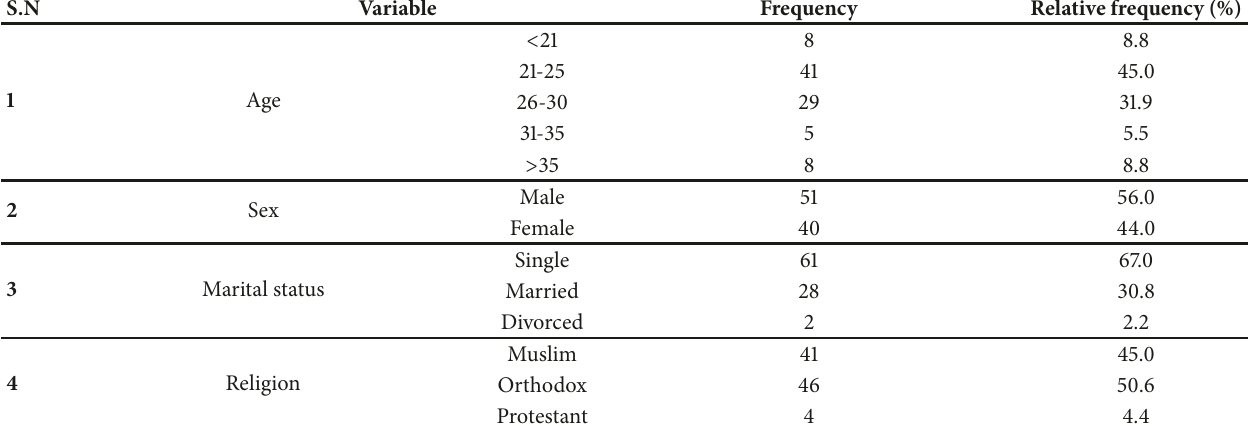
Table 1: Sociodemographic characteristics of health professionals in Dubti Referral Hospital, April 2016. S.N